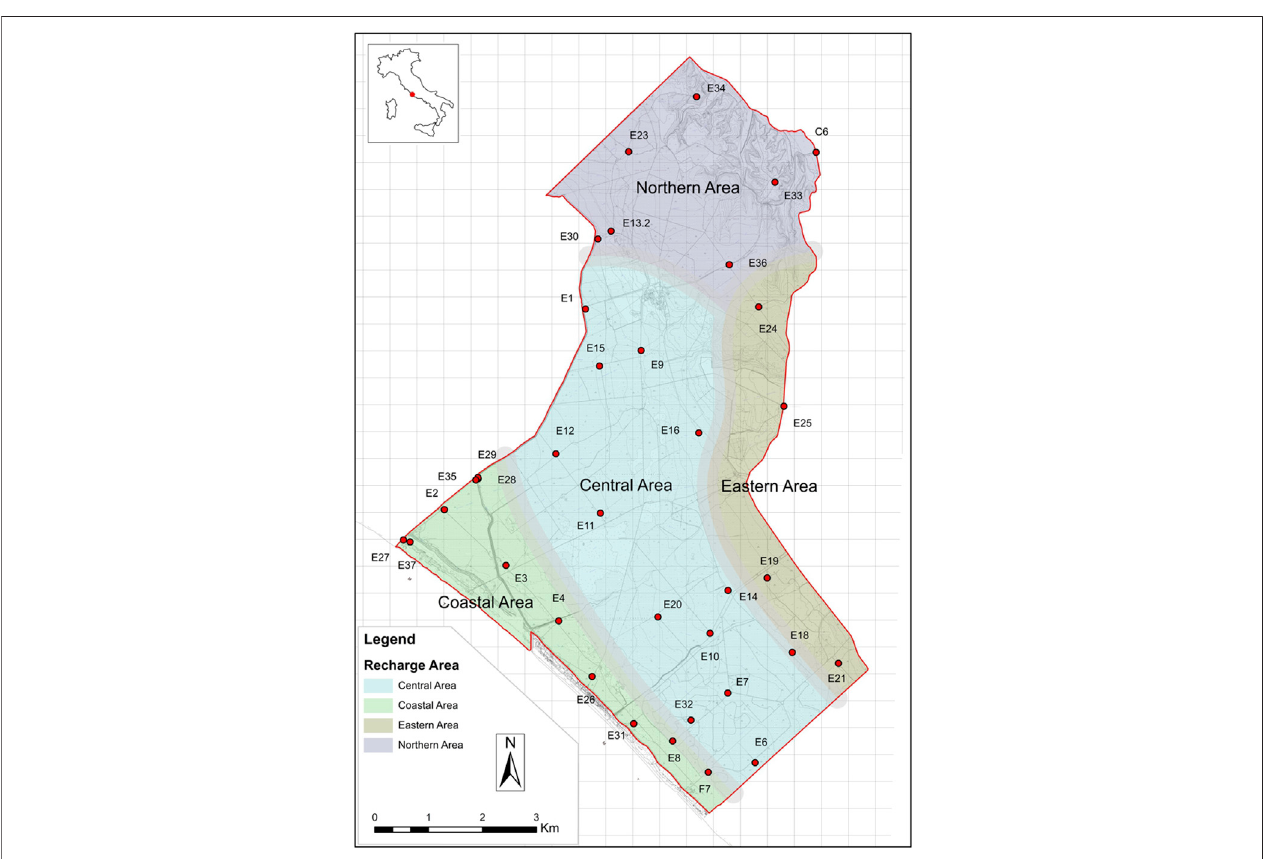
FIGURE 6 | Location map of the four identi fi ed recharge areas.